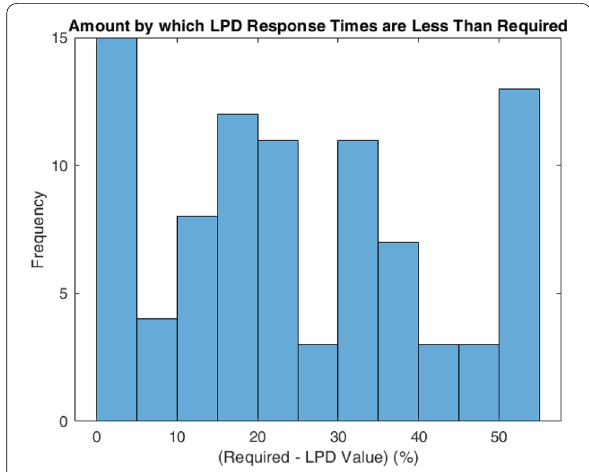
Fig. 7 Histogram of (cid:31) RT Rreq : LPD . LPD always met the requirement (all 104 models)